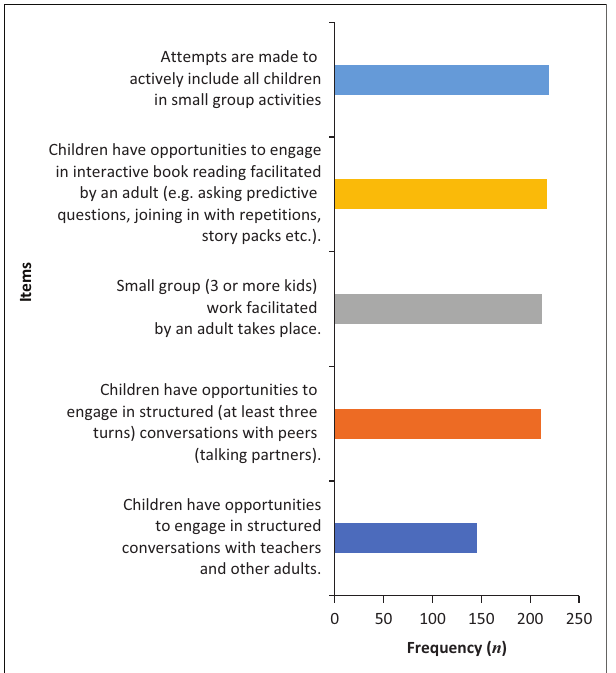
FIGURE 4: Frequency of items observed – Language-learning opportunities (scores ≤